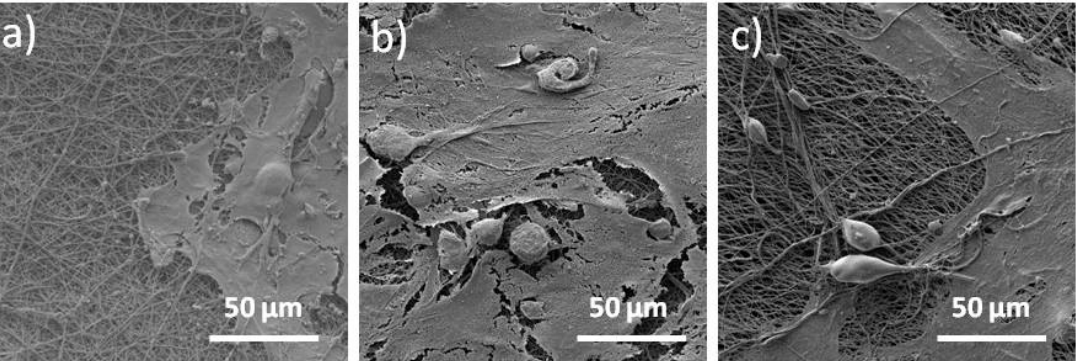
Figure 14. SEM photomicrographs of the adhered Limbal stem cells (LSCs) on the electrospun scaffolds: ( a ) PCL, ( b ) PCL/5 wt % CF and ( c ) PCL/m-TiO 2 .